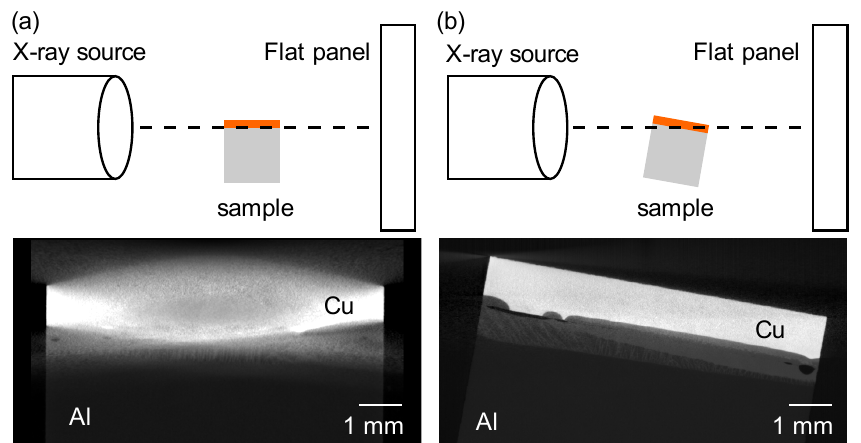
Figure 2. Schematic of the sample orientation in the beam path and change in artefacts in cross- sections from the tomographies: ( a ) parallel, ( b ) tilted by 10° to the beam direction.